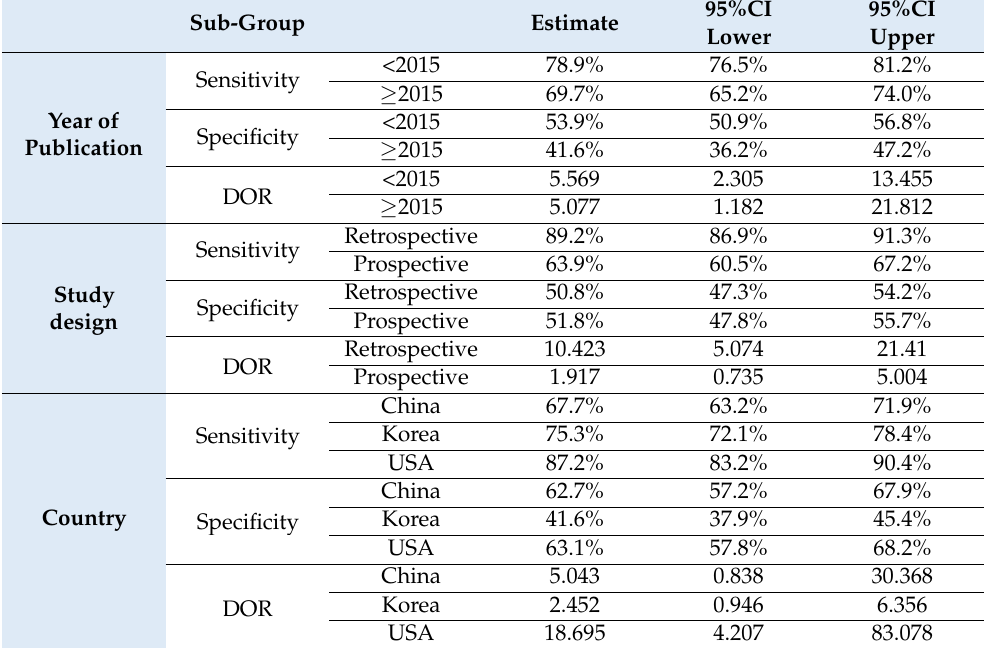
Table 3. Meta-regression analysis of parameters influencing extrathyroidal extension detection accuracy on ultrasound.